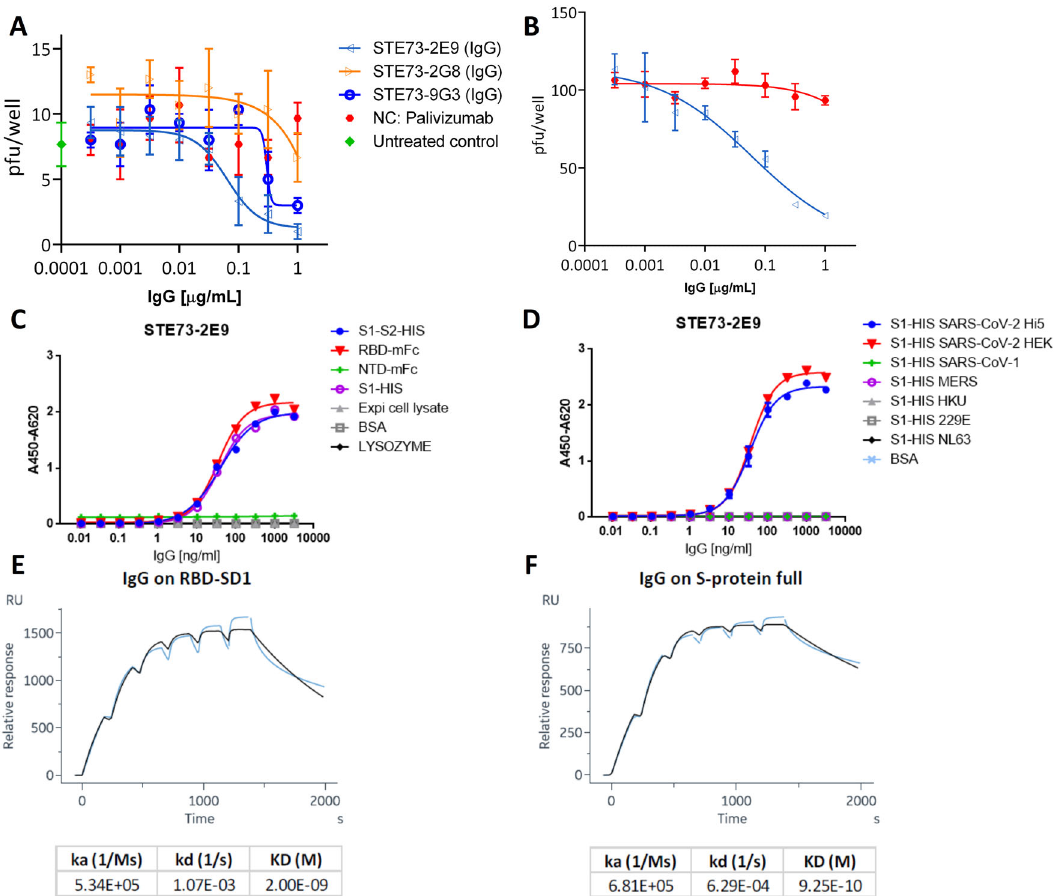
Fig. 7 Characterization of the neutralizing antibody STE73-2E9 in IgG format. A Neutralization of 20 – 30 pfu SARS-CoV-2 by STE73-2E9, -9G3, and -2G8. Palivizumab was used as isotype control. B Validation of neutralization potency of STE73-2E9 using 100 pfu. Neutralization assays were performed in triplicates, mean ± s.e.m. are given. C Titration ELISA on the indicated antigens. ELISA shows single titration of two representative experiments (see also Supplementary Fig. 7). D Cross-reactivity to other coronavirus spike proteins analzyed by ELISA. S1-HIS SARS-CoV-2 Hi5 was produced in house. S1-HIS SARS-CoV-2 HEK and all other coronavirus S1 domain proteins were obtained commercially. ELISA experiments were performed in duplicate and the mean values are given. E , F Kinetic parameter determination through single-cycle kinetic titration SPR of STE73-2E9 IgG on HEK cell produced RBD-SD1 and S1- S2, respectively (concentrations: 200, 100, 50, 25, 12.5, 6.25